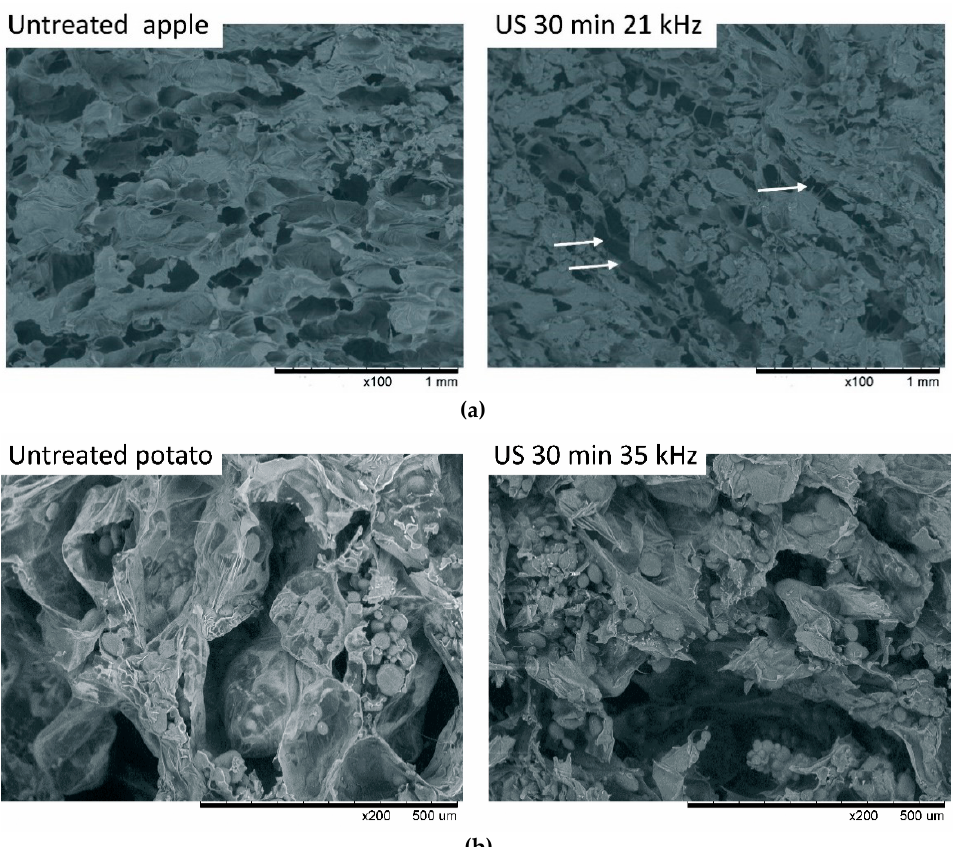
Figure 2. The influence of ultrasound treatment on the structure of: apple ( a ); and potato ( b ). The magnification is 100 × and 200 × , respectively. Own unpublished data. The white arrows indicate microchannels.